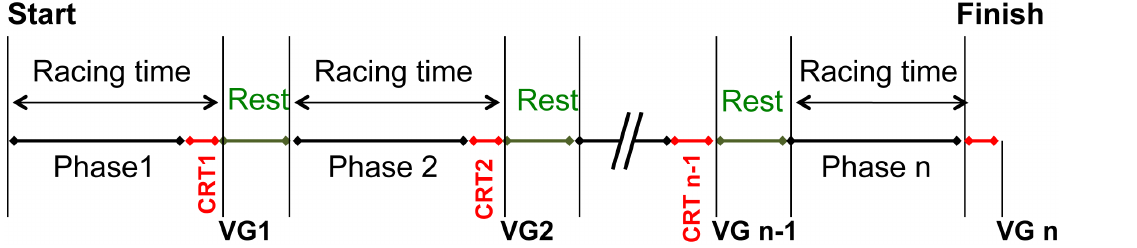
Fig 1. Schematic diagram of an endurance event. The competition is divided into phases of 30 – 40 km that are followed by 40- to 50-minute rest periods. Horses are checked by veterinarians at the vet gates (VGs) between each phase. The HR must be below 65 bpm when the horse is examined at the vet gate. The cardiac recovery time (CRT) is defined as time interval between the end of the phase and presentation at the vet gate; it counts towards the total running time.